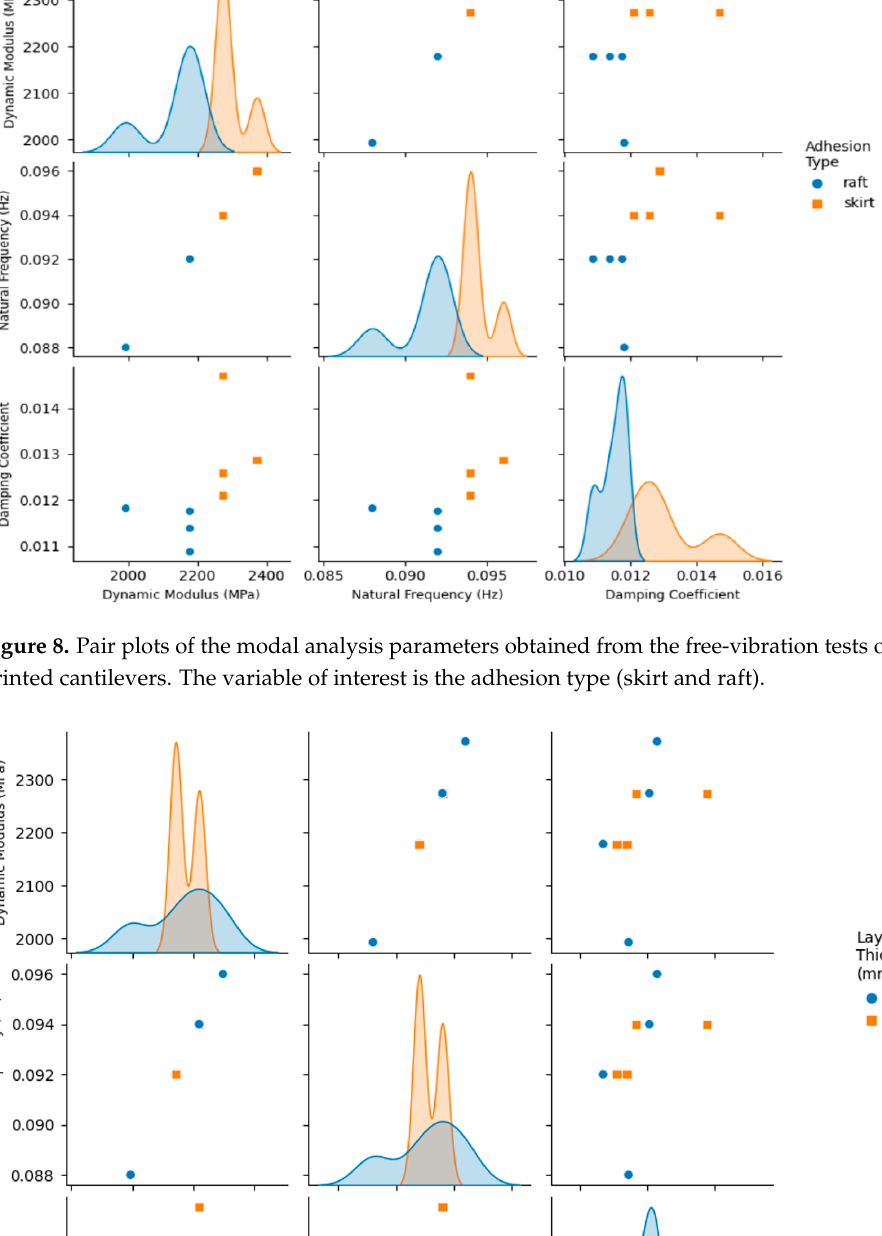
Figure 7. Frequency-domain response of the 3D printed cantilevers: ( a ) R-45-0.18 mm, ( b ) R-90-0.18